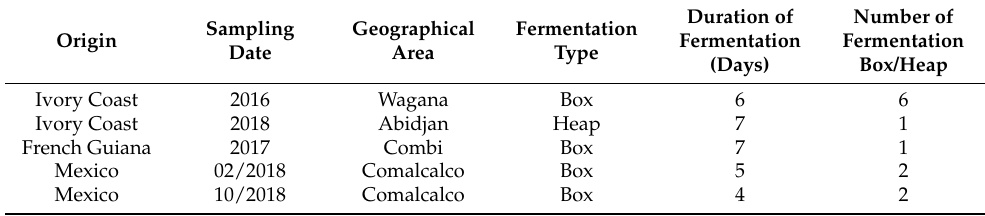
Table 1. Data concerning the cocoa bean